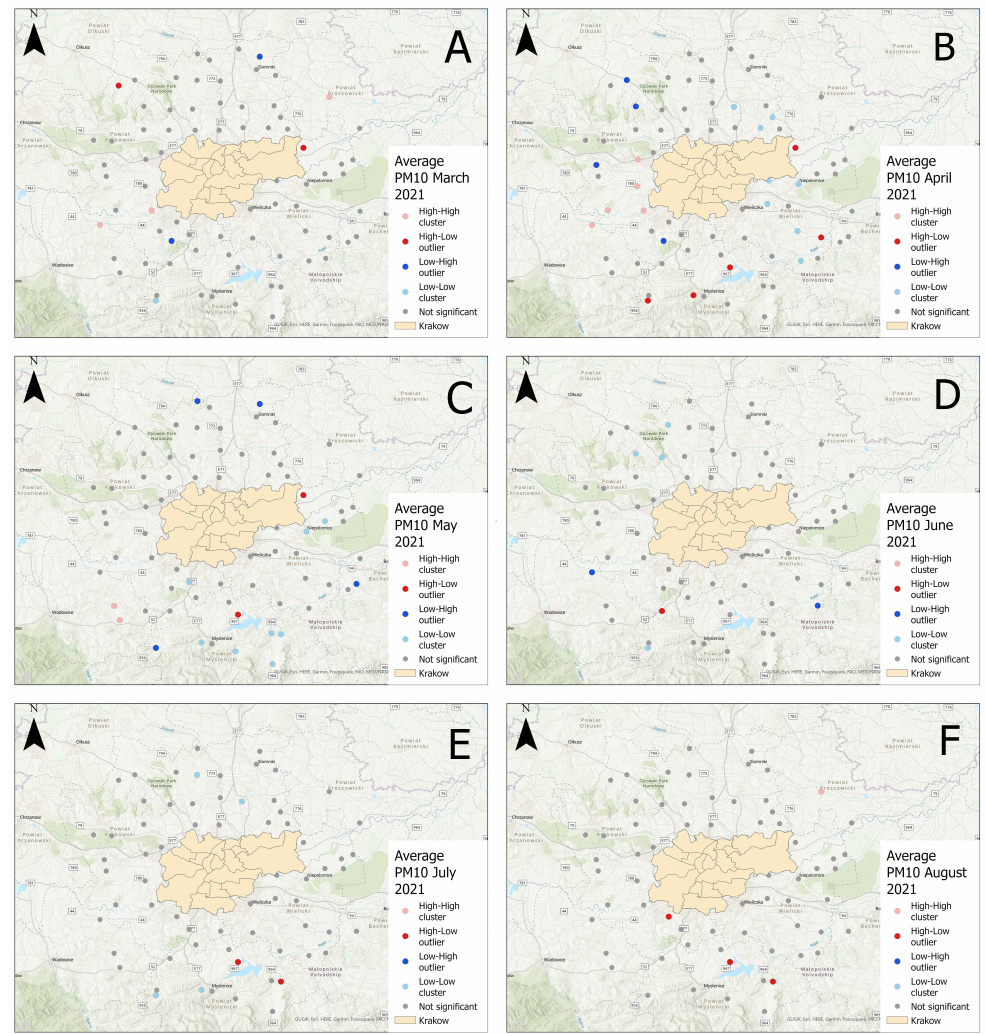
Figure 9. The spatial associations for monthly average PM10 concentrations showing high-high and low-low clusters and high-low and low-high outliers using Local Moran’s I. The maps illustrate clustering in March ( A ),April ( B ), May ( C ), June ( D ), July ( E ), and August 2021 ( F